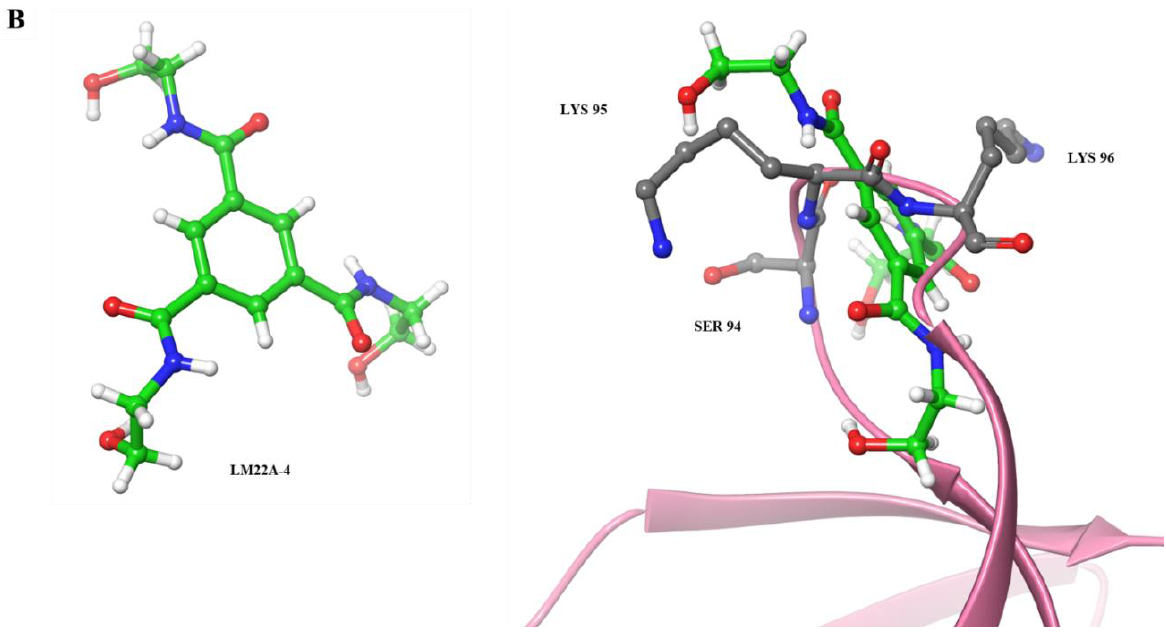
Figure 7. ( A ) Representation of the BDNF chain A crystal structure (PDB: 1B8M [35]) and its loop II. ( B ) Representation of the LM22A-4 and its alignment with the sub region b on the BDNF loop II.